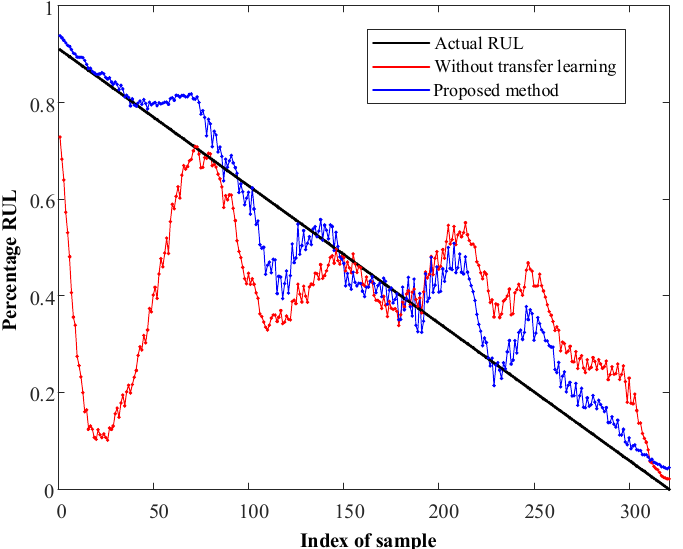
Figure 5 .RUL prediction of bearing3_3 in Case I.